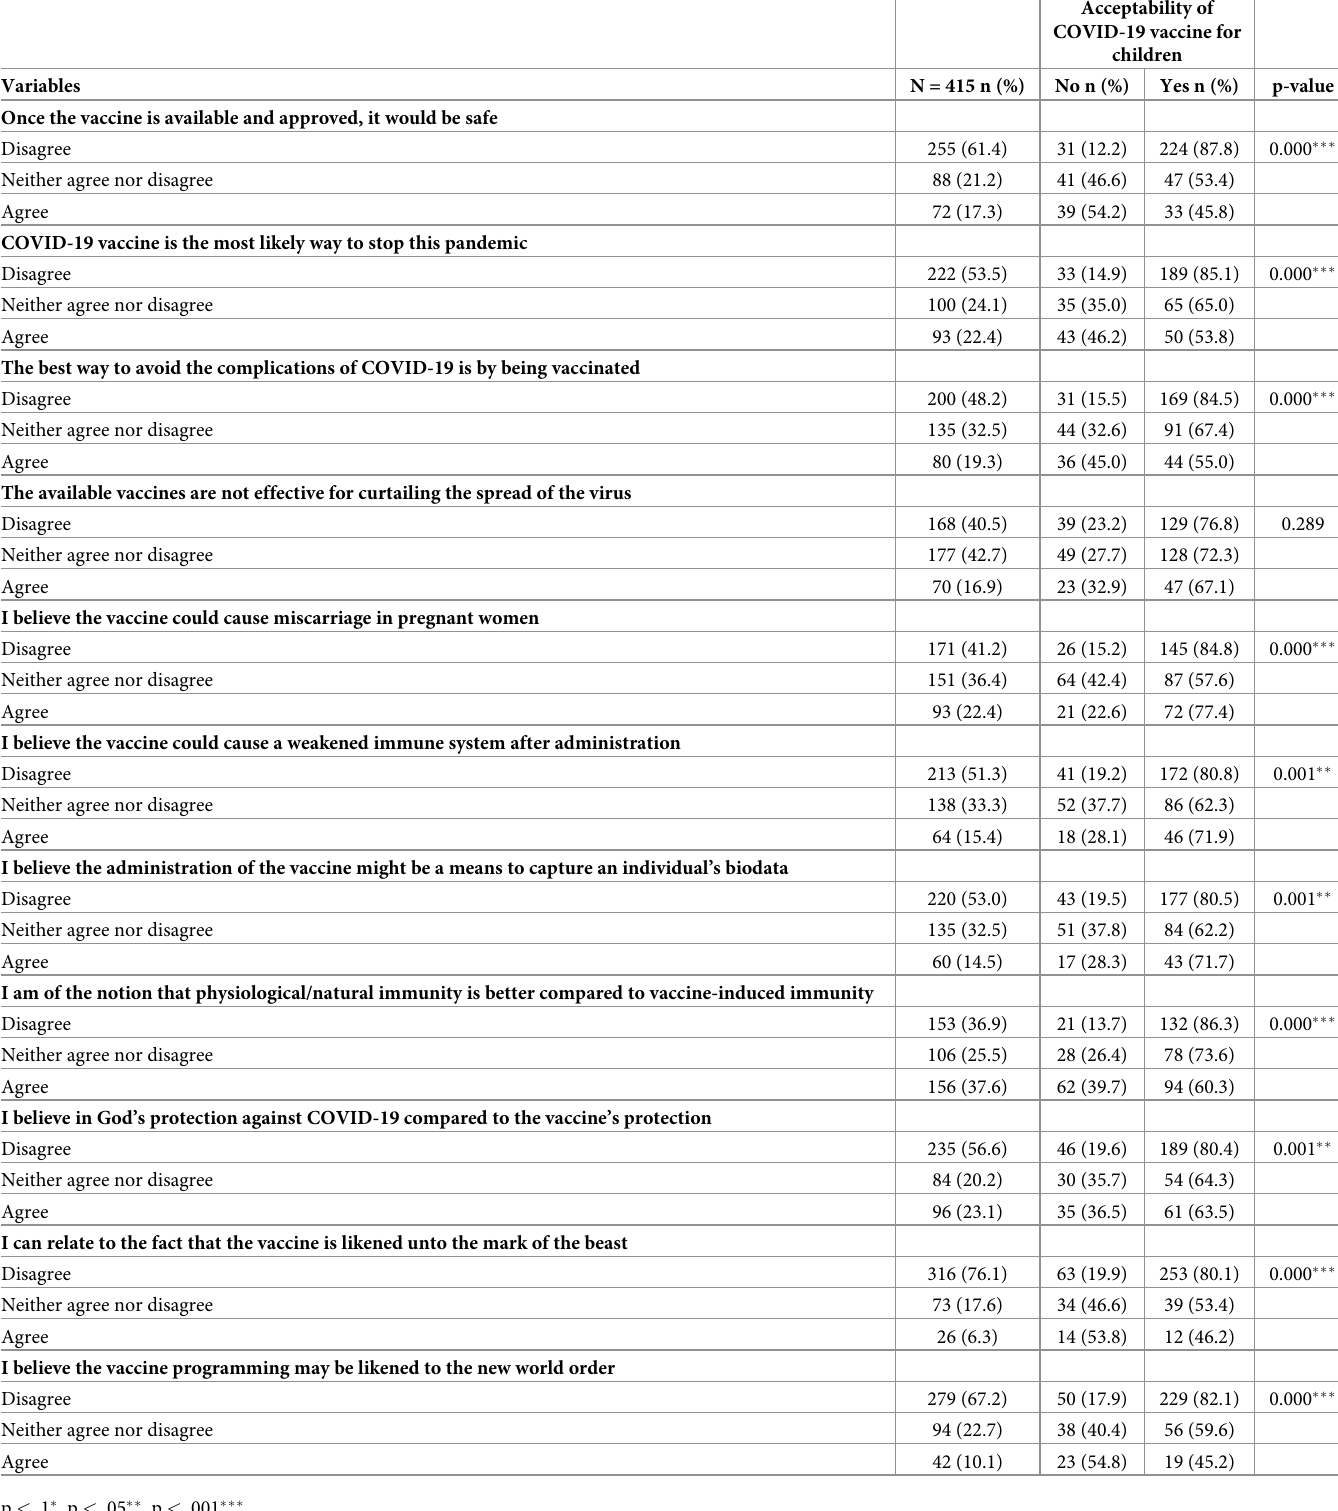
Table 4. Beliefs about COVID-19